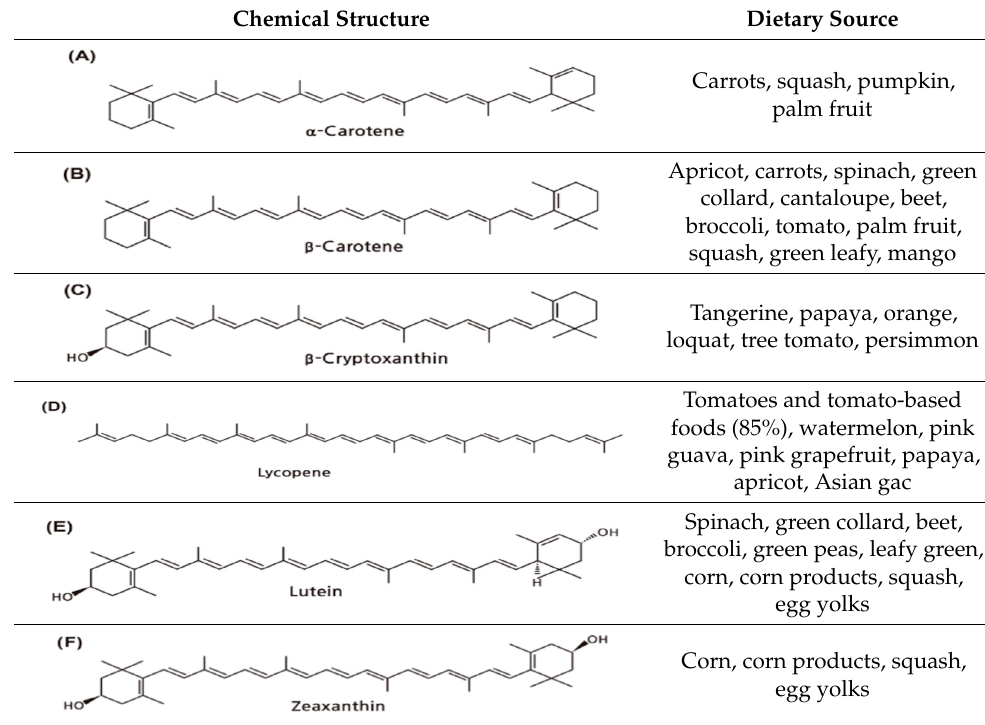
Table 2. Major dietary carotenoids and their common sources. Chemical